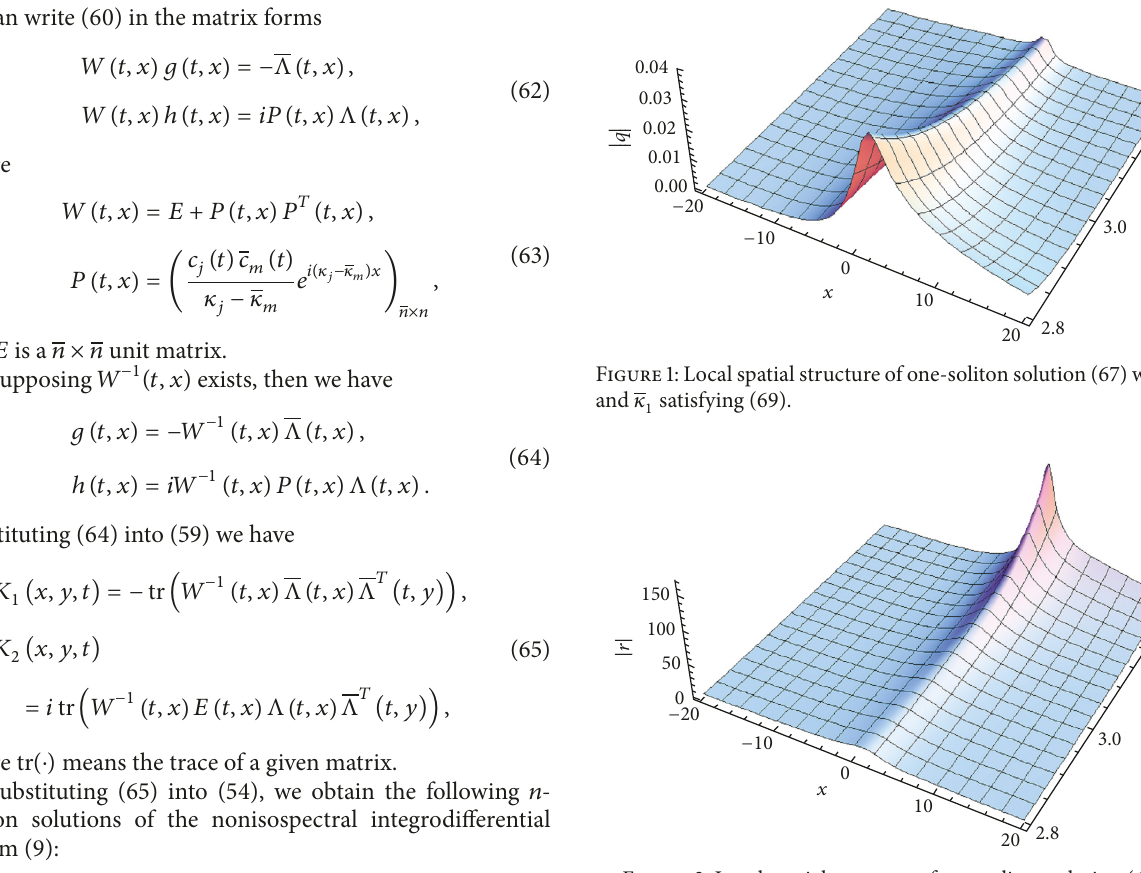
Figure 2: Local spatial structure of one-soliton solution